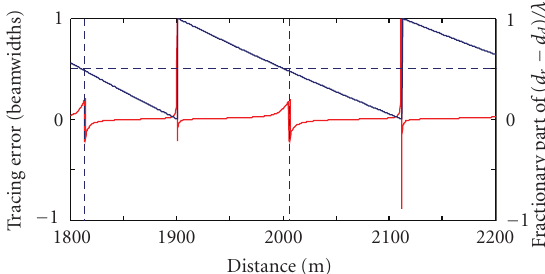
Figure 11: Tracking error (red curve) for a crossfeed monopulse as a function of distance. The blue curve shows the di ff erences between the direct and reflected paths as fractions of